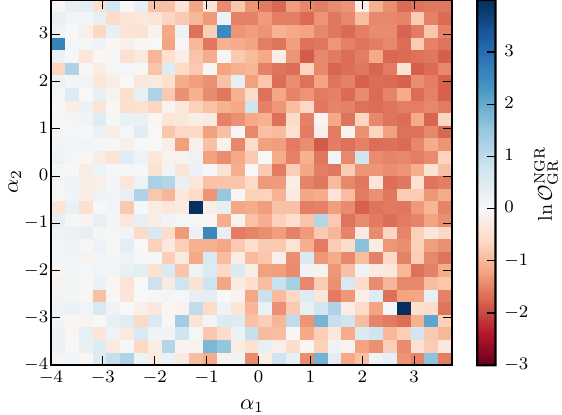
FIG. 16. Odds ratios O NGR obtained for simulated Advanced GR LIGO observations of tensor-polarized broken power-law back- grounds with energy density spectra given by Eq. (13). The parameters α 1 and α 2 are the backgrounds ’ slopes below and above the “ knee ” frequency f k , which we take to be 30 Hz (in the center of the stochastic sensitivity band). We scale the amplitude Ω 0 of each background such that it is optimally detectable with h SNR i ¼ 5 after the simulated observation period. By design, OPT these backgrounds are not well described by single power laws, the form explicitly assumed in our search. Despite this fact, we find that these backgrounds are not systematically misclassified as containing vector or scalar